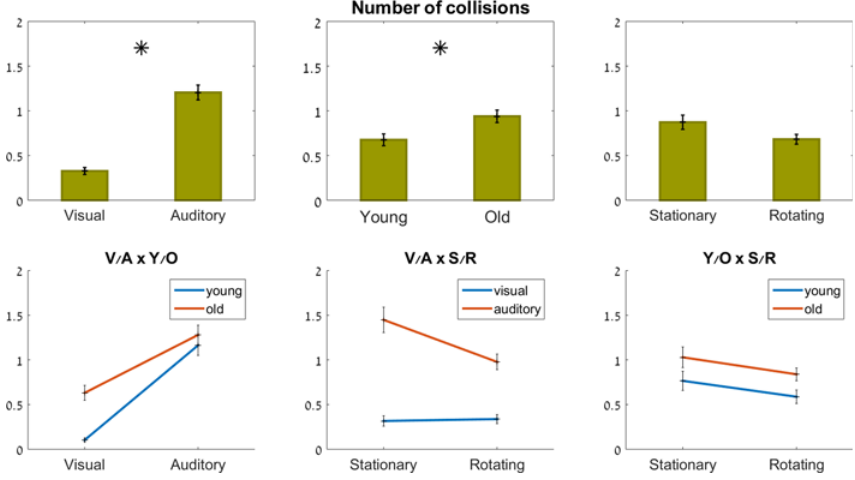
Fig 8. Number of collisions. Top row: main effects; bottom row: interaction effects (ns). Significant effects marked with an asterisk.